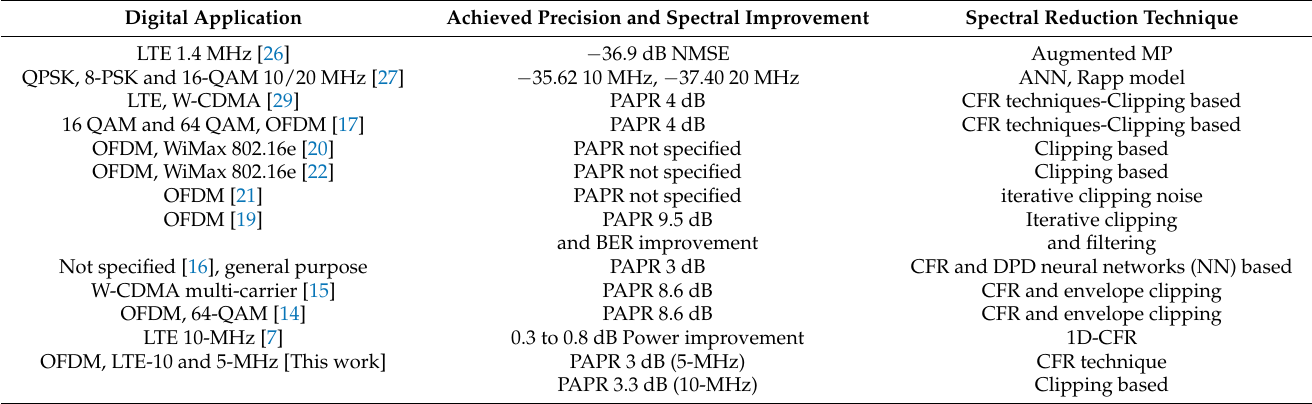
Table 5. Comparison of spectral improvements and applied techniques for digital